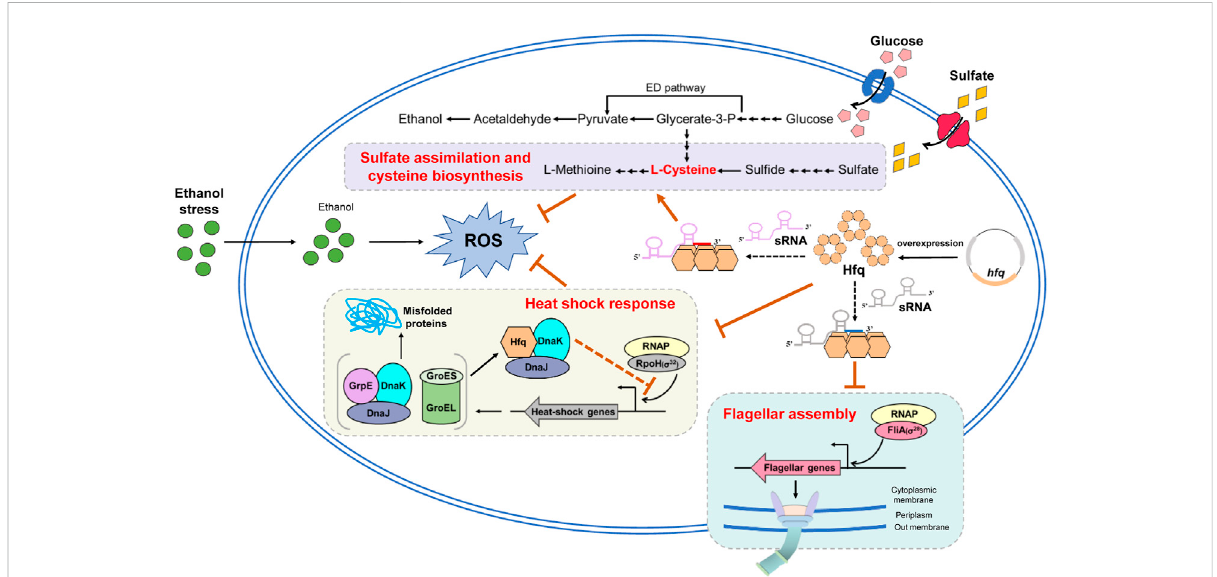
FIGURE 6 Proposed molecular mechanism of enhanced ethanol tolerance associated with hfq overexpression in Z. mobilis. Hfq overexpression helps negatively regulate the fl agellar related genes and conserve energy for ethanol stress response and cell growth. Moreover, Hfq overexpression enhances sulfate assimilation and cysteine biosynthesis and eliminates the oxidative stress induced by ethanol inhibition. In addition, Hfq indirectly modulates the RpoH through interaction with DnaK/J and appropriately regulates the RpoH-mediated heat shock response under ethanol stress. ED pathway, Entner-Doudoroff pathway; ROS, reactive oxygen species. The orange arrows and orange bars represent upregulate and downregulate, respectively. Solid lines in this fi gure represent the con fi rmed regulations and dotted lines represent that are not yet con fi